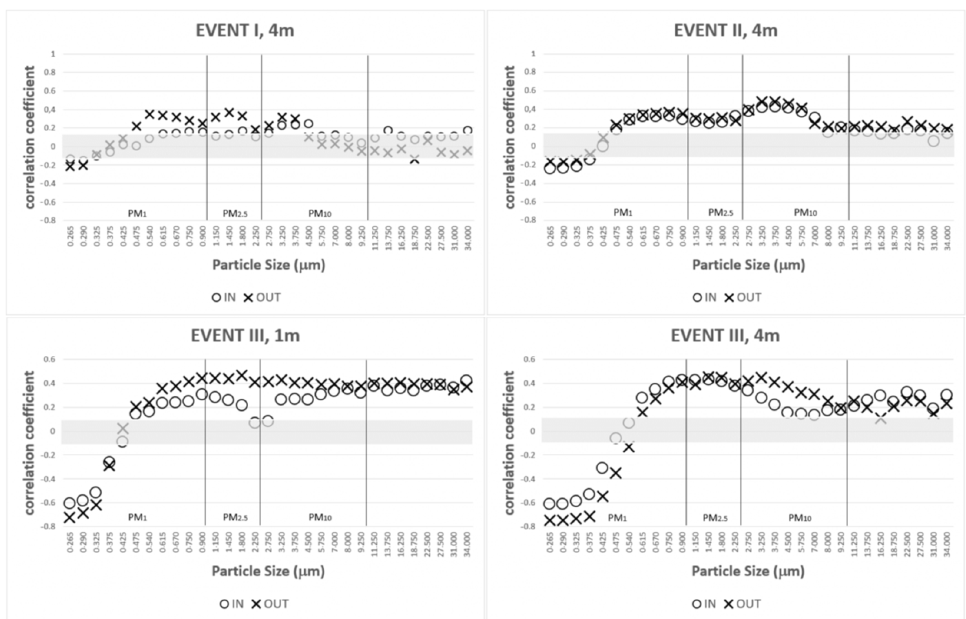
Figure 7. Linear Pearson correlation coefficients for the 1 min measurements between wind speed and particle counts for 31 particle size classes. The grey shadow indicates non ‐ significant correlation coefficients ( α = 0.05). At Event I and II the 1 m particle count data were lost during the field campaign and cannot be shown here. For comparison reasons, the respective particulate matter classes are also displayed.